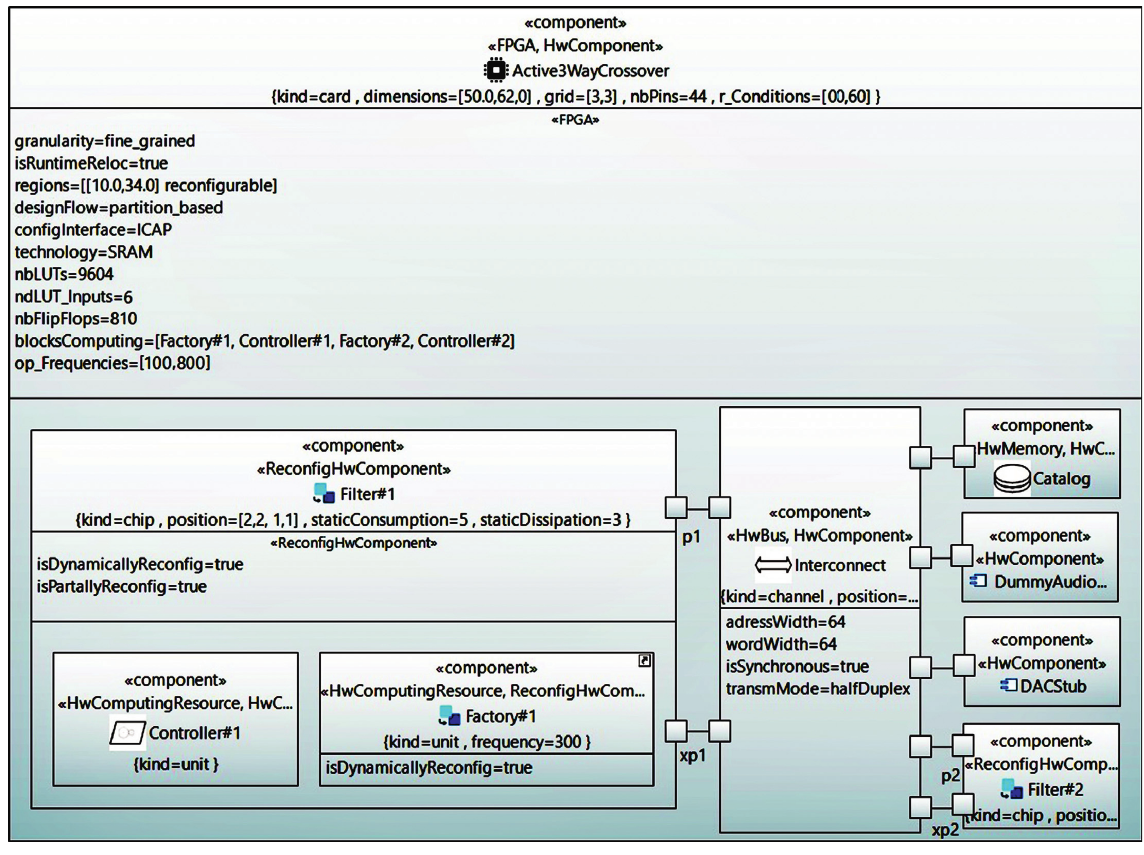
Figure 16: Merged logical physical view.